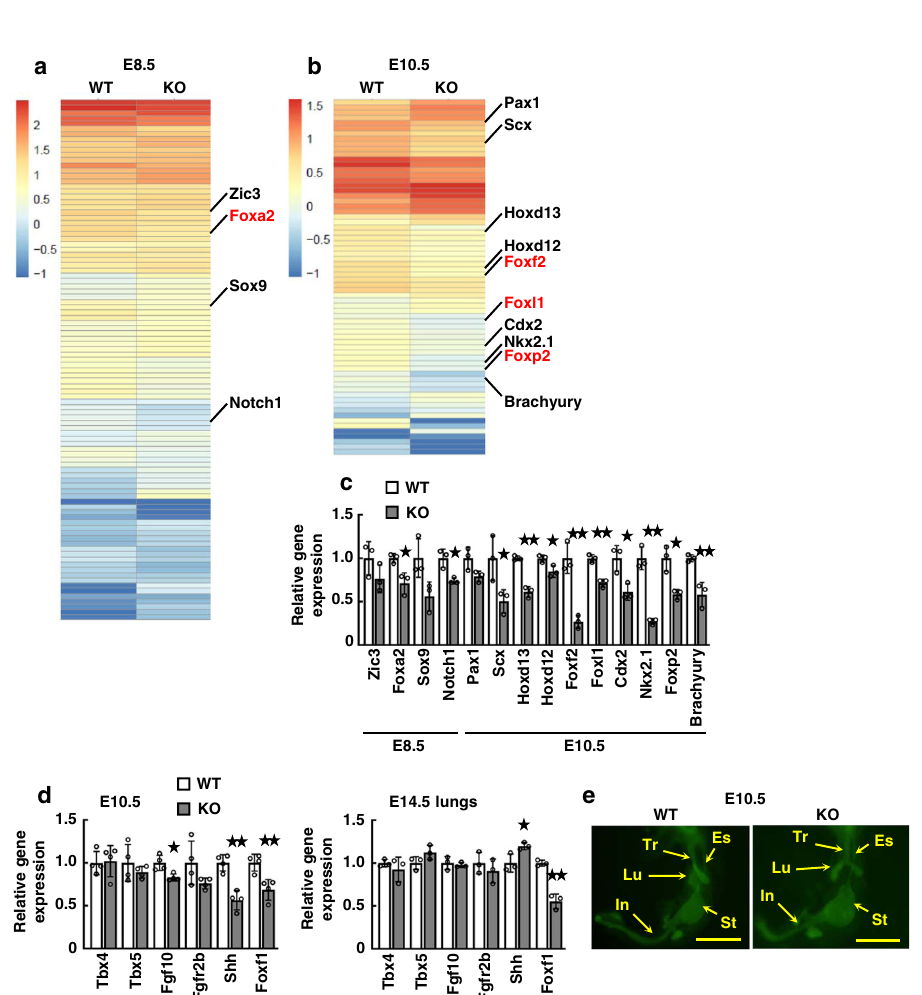
Fig. 3 Dyrk2 − / − mice show reduced Foxf1 expression. Dyrk2 − / − mice display reduced expression of organogenesis associated genes. a , b Heatmap of genes related to transcription from GO analysis in E8.5 ( a ) and E10.5 ( b ) embryos. c Relative expression of genes related to developmental defect in E8.5 and 10.5 embryos ( n = 3). d Relative expression of genes related to lung development in E10.5 embryos and E14.5 lungs (E10.5: n = 4; E14.5 lung: n = 3). e The representative foregut of E10.5 embryos from WT and Dyrk2 − / − mice with the epithelium outlined by whole-mount E-cadherin immunostaining. Tr trachea, Es esophagus, Lu lung, St stomach, In intestine. Data are presented as the mean ± SD in c , d . * p < 0.05; ** p < 0.01. Scale bar: 500 μ m in e